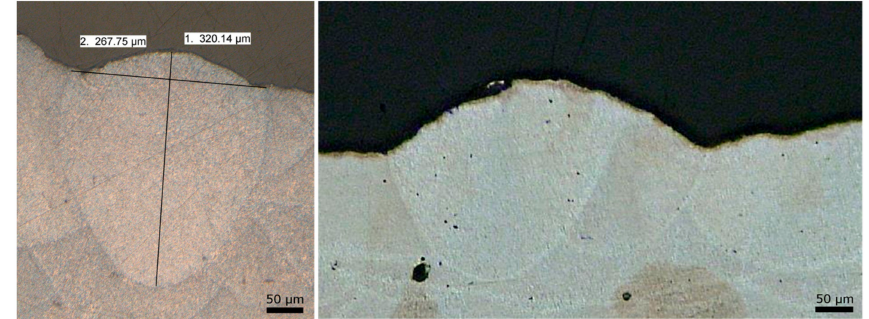
Figure 3. The two examined types of laser tracks. Left : Primary track . Right : Secondary track .